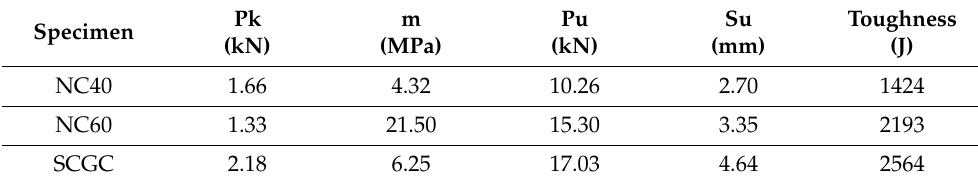
Table 7. Average results of load and end